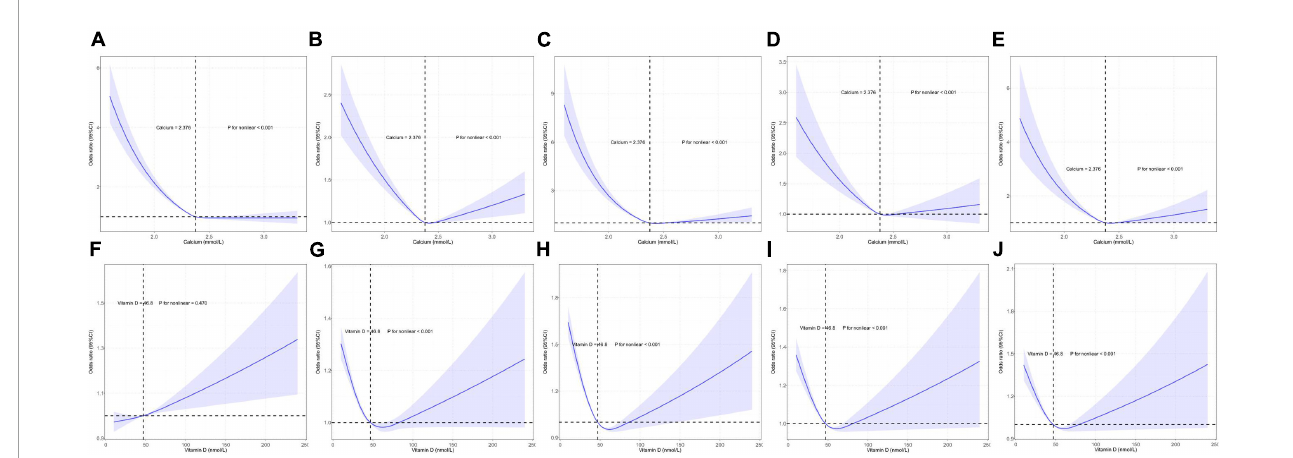
FIGURE3 Restricted cubic spline model-based analyses of the association between serum calcium (Ca)/vitamin D (VD) levels and the risk of cardiovascular diseases (CVDs). (A–E) Curvilinear relationships between serum Ca levels and atrial fibrillation (AF), coronary artery disease (CAD), heart failure (HF), myocardial infarction (MI), and stroke. (F–J) Curvilinear relationships between VD concentrations and AF, CAD, HF, MI, and stroke. The y -axis represents the log of logistic regression model-derived odds ratios (ORs), while the shaded area denotes the corresponding 95% confidence interval (CIs) for these adjusted ORs. A plateau in CVD risk was evident in the risk